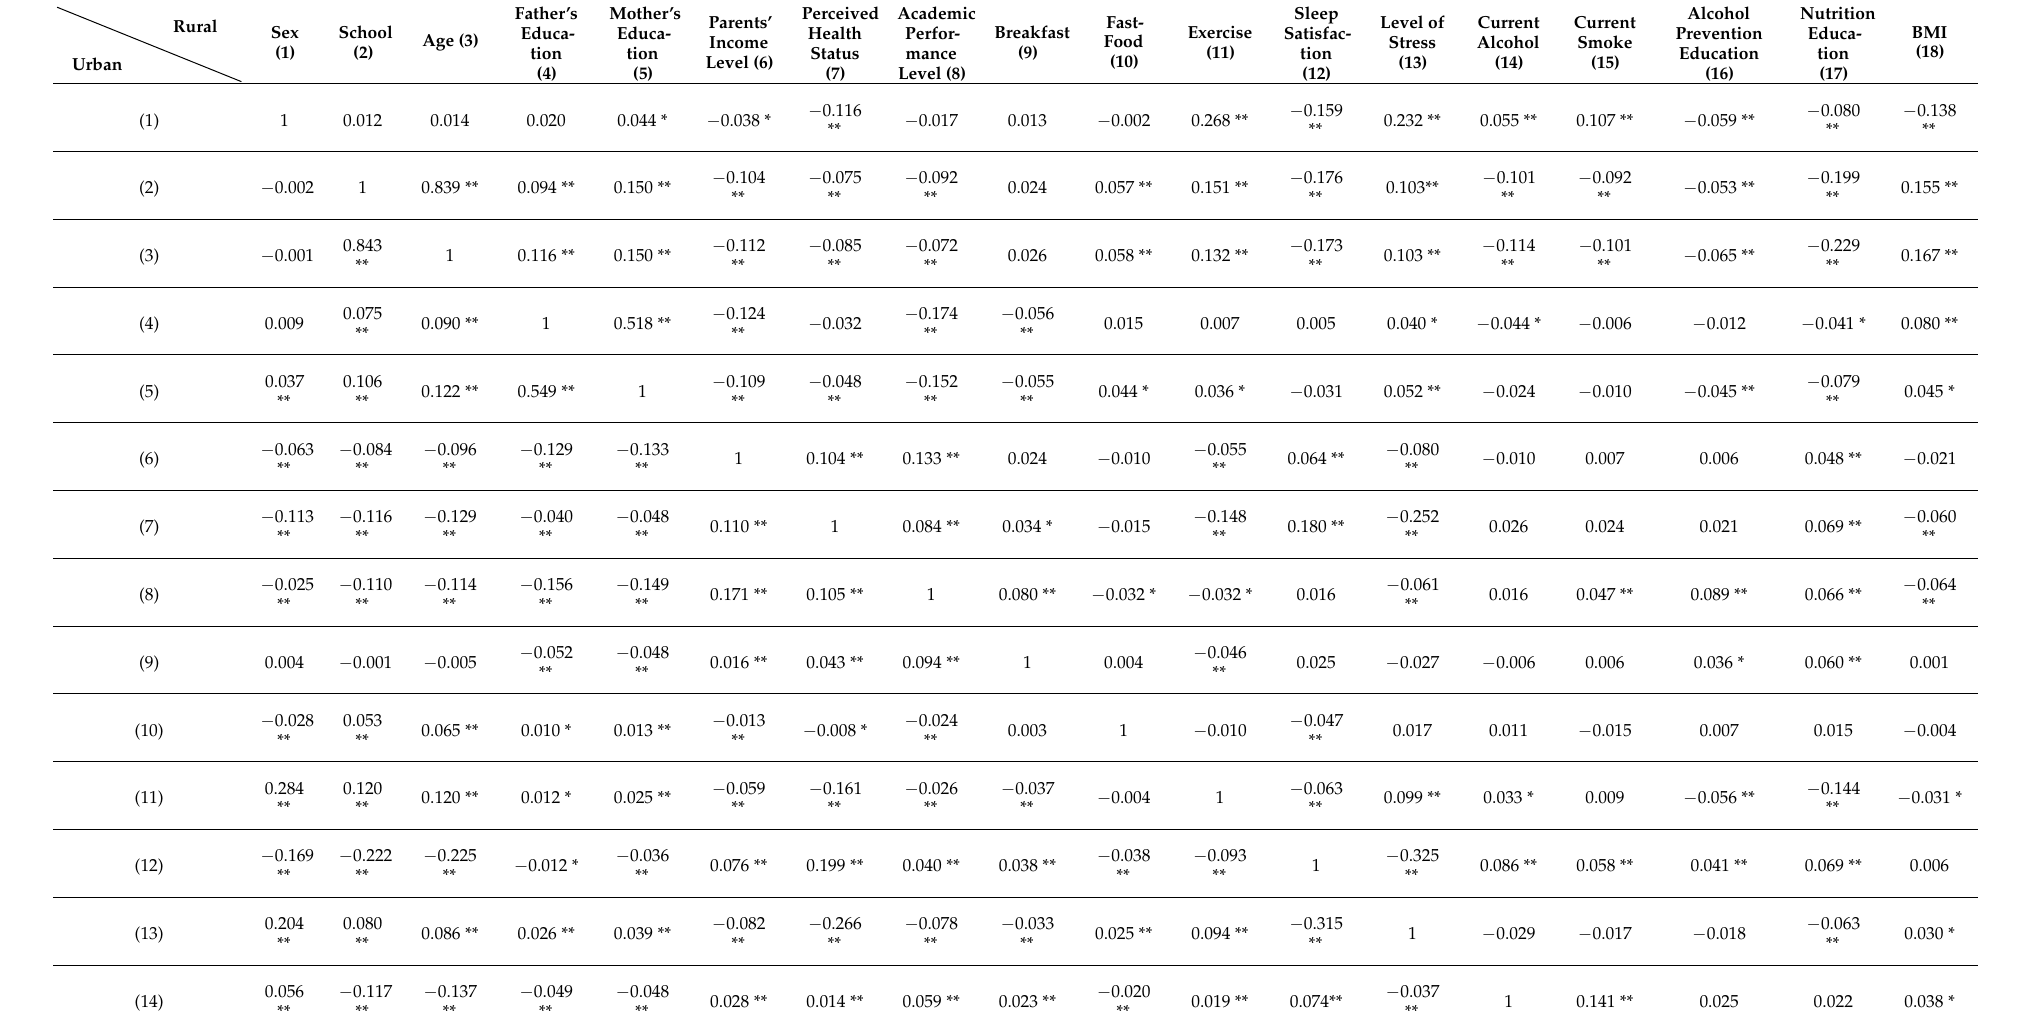
Table 2. Correlation of variables in urban and rural